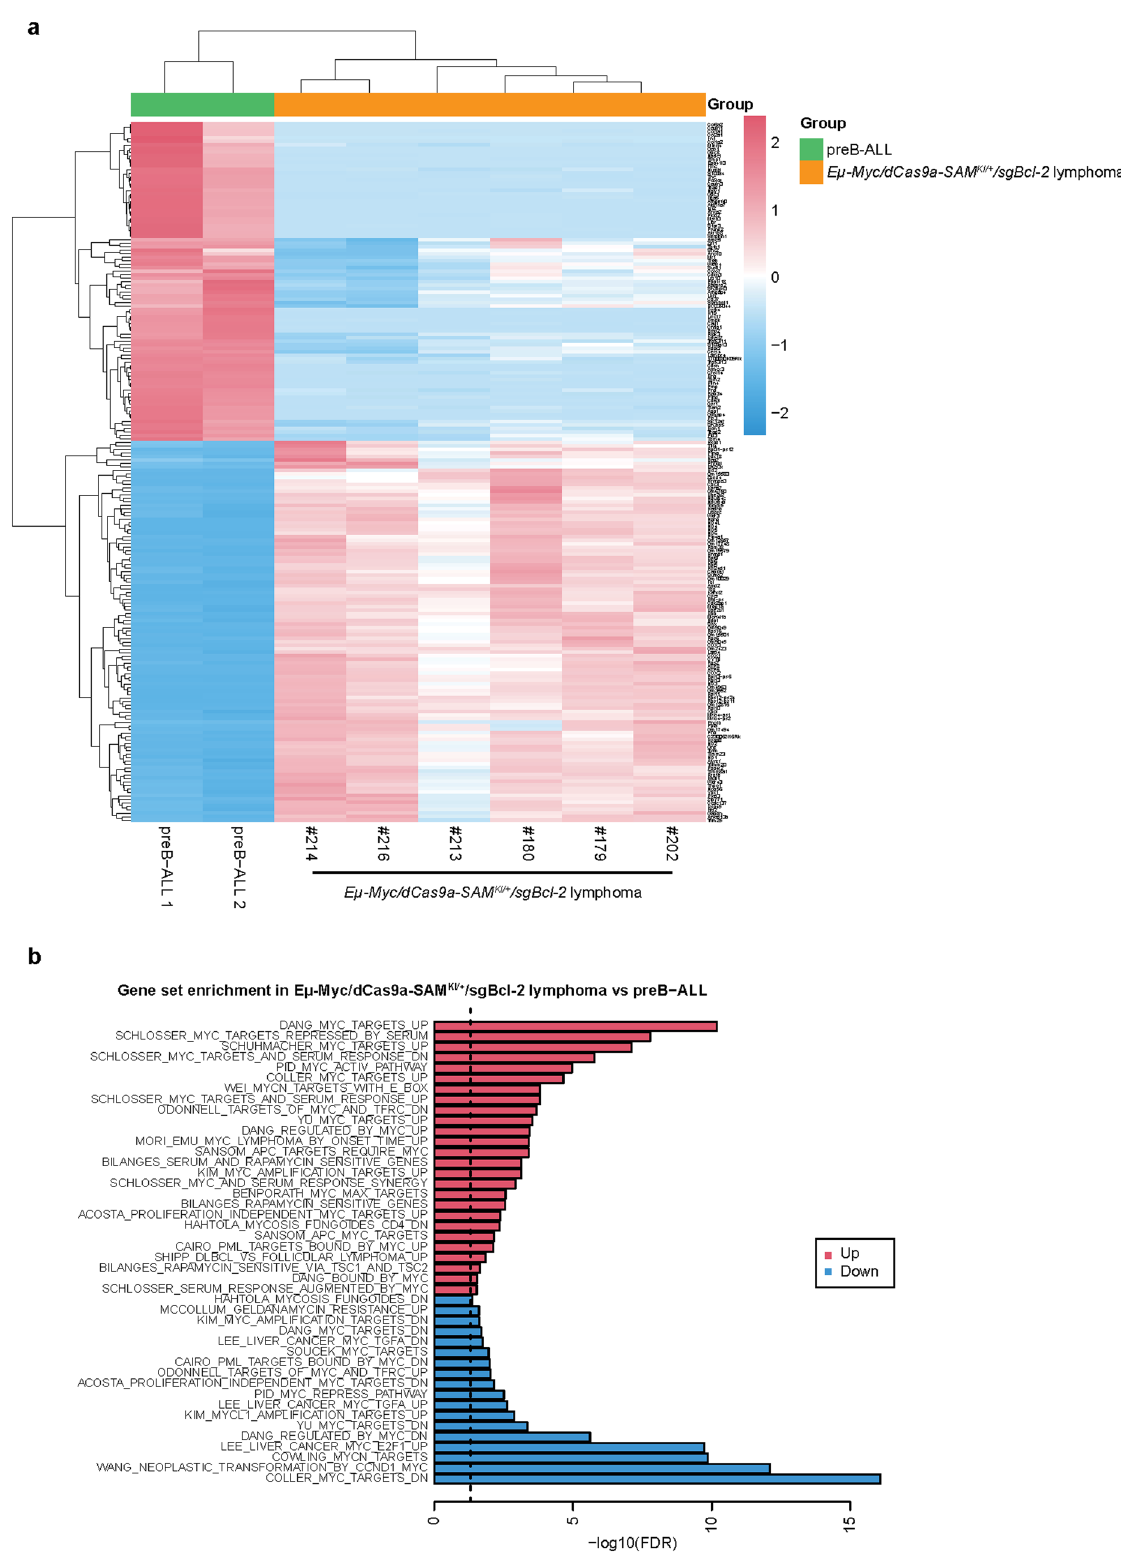
Fig.6|TheRNA-seqanalysiscomparingthegeneticpatternsof E µ -Myc/dCas9a- SAM KI/+ /sgBcl-2 lymphomas vs preB-ALL. a Heatmap ofthe top 200most variable genescomparingtwopreBacutelymphoblasticleukaemiasamples(preB-ALL)and six E µ -Myc/dCas9a-SAM KI/+ /sgBcl-2 tumours demonstrating distinct transcriptional